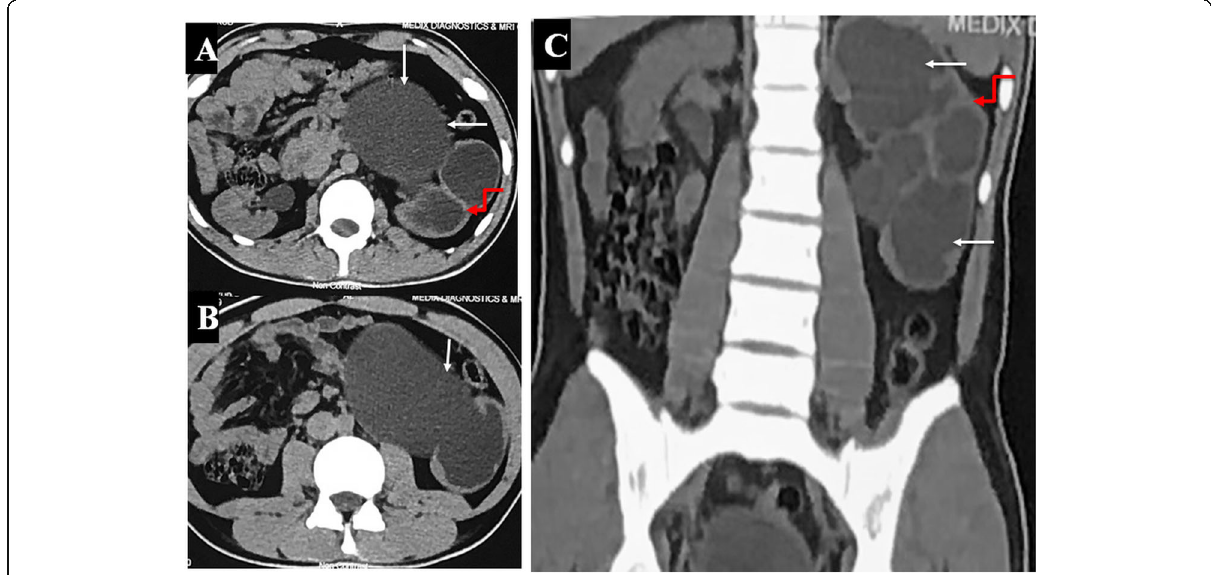
Fig. 1 Axial ( a , b ) and coronal ( c ) non-contrast-enhanced CT (NCCT) scan images showing gross hydronephrosis of the left kidney (white arrows) with severe parenchymal thinning (curved red